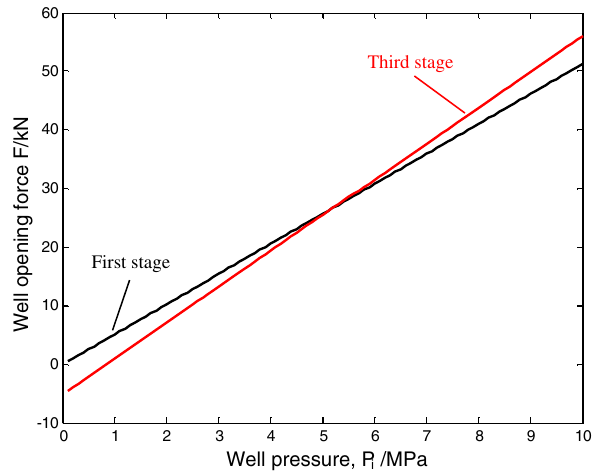
Fig. 12 Relationship between well opening force and oil